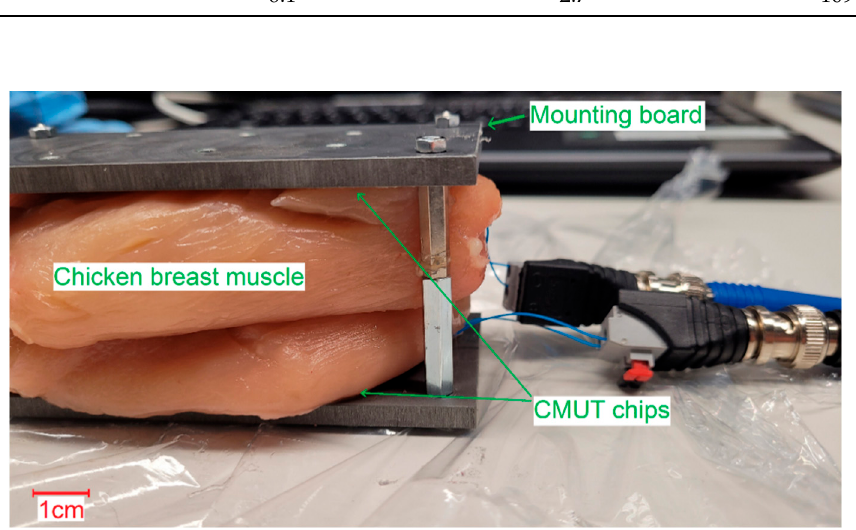
Figure 12. Transmission path for ex vivo experiments.